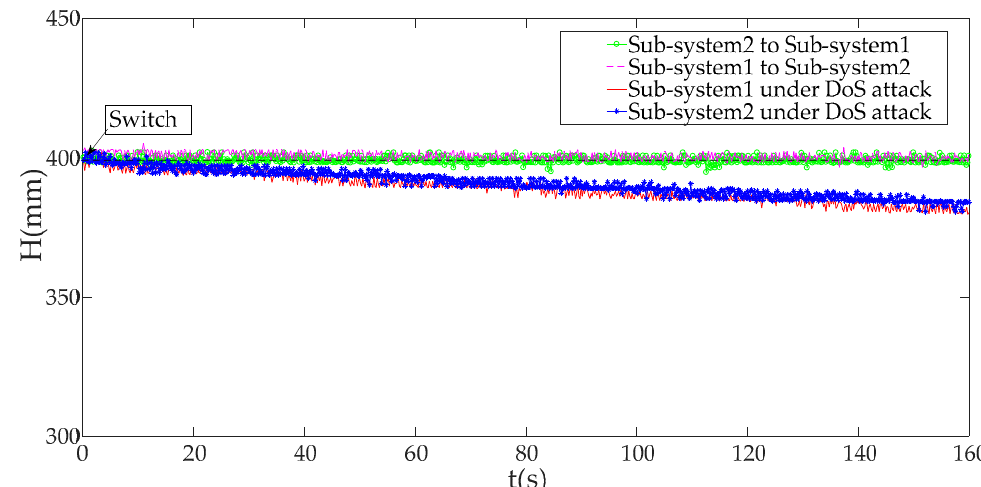
Figure 19. Different system responses before and after using the switch strategy.